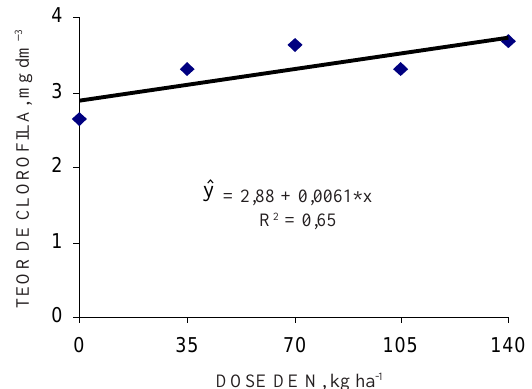
Figura 2. Teor de clorofila nas folhas de feijoeiro, no florescimento pleno, em função da dose de nitrogênio. * significativo a 5%, pelo teste